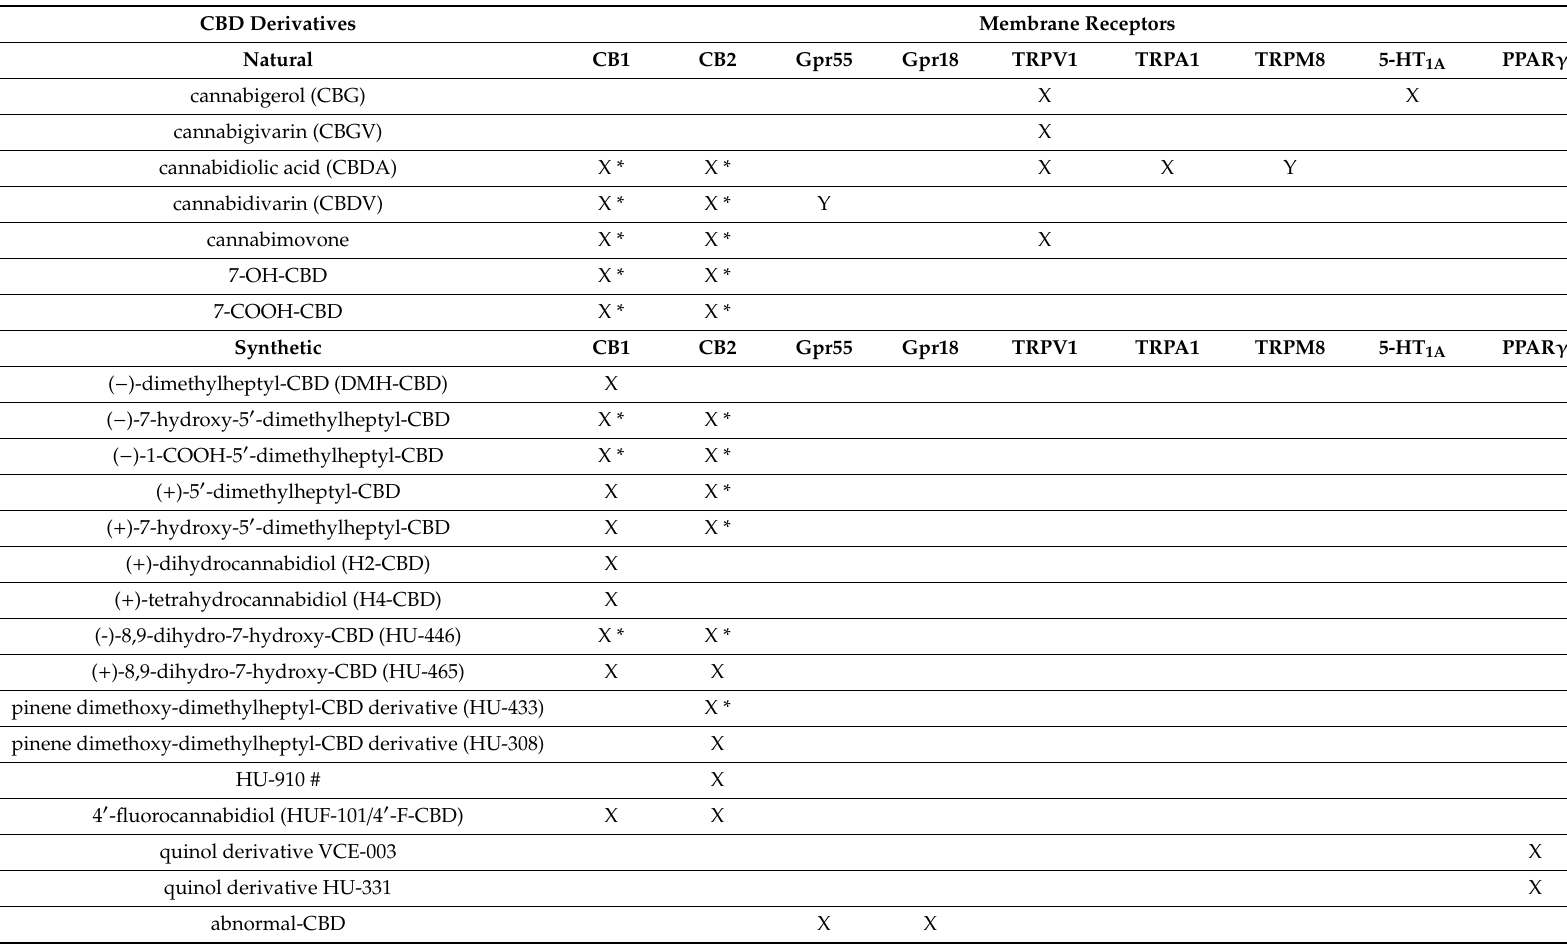
Table 2. Influence of natural and synthetic CBD derivatives on receptor activation (X: agonist activation or Y: antagonist activation by related CBD derivative; * weak a ffi nity; #: full name is in chapter 4.1)